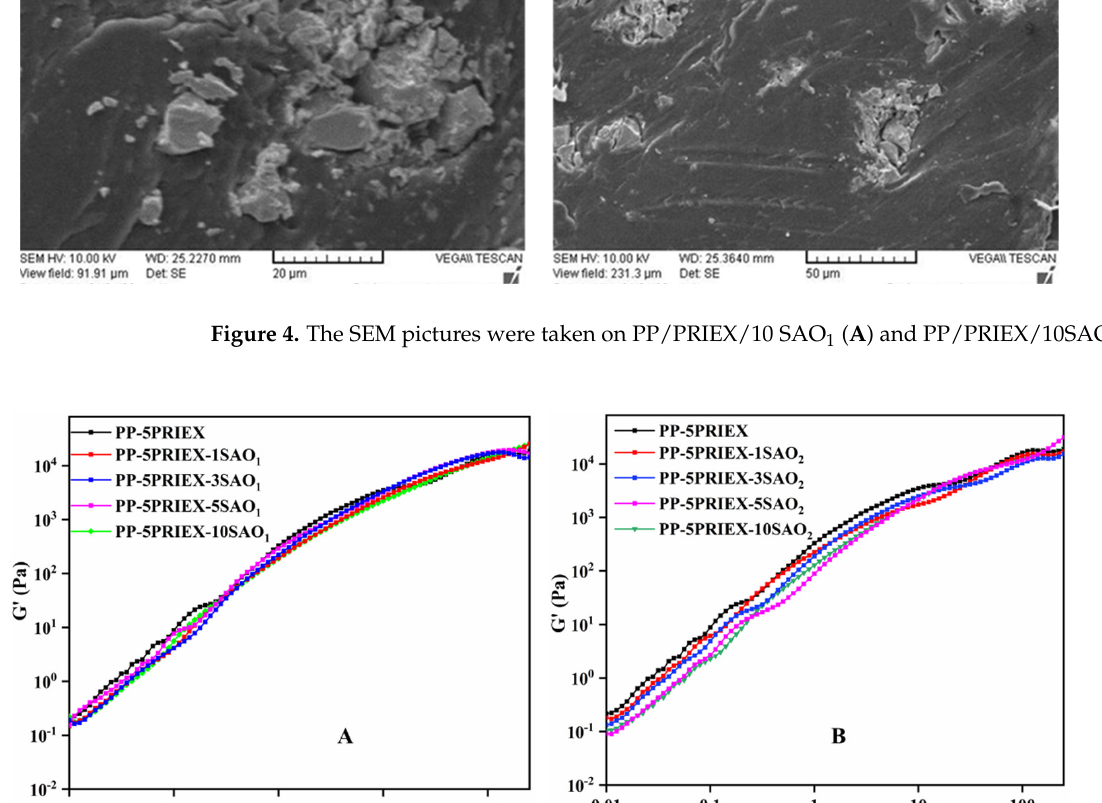
Figure 5. The storage modulus of PP/PRIEX / SAO 1 ( A ) and PP/PRIEX / SAO 2 ( B ) composites .